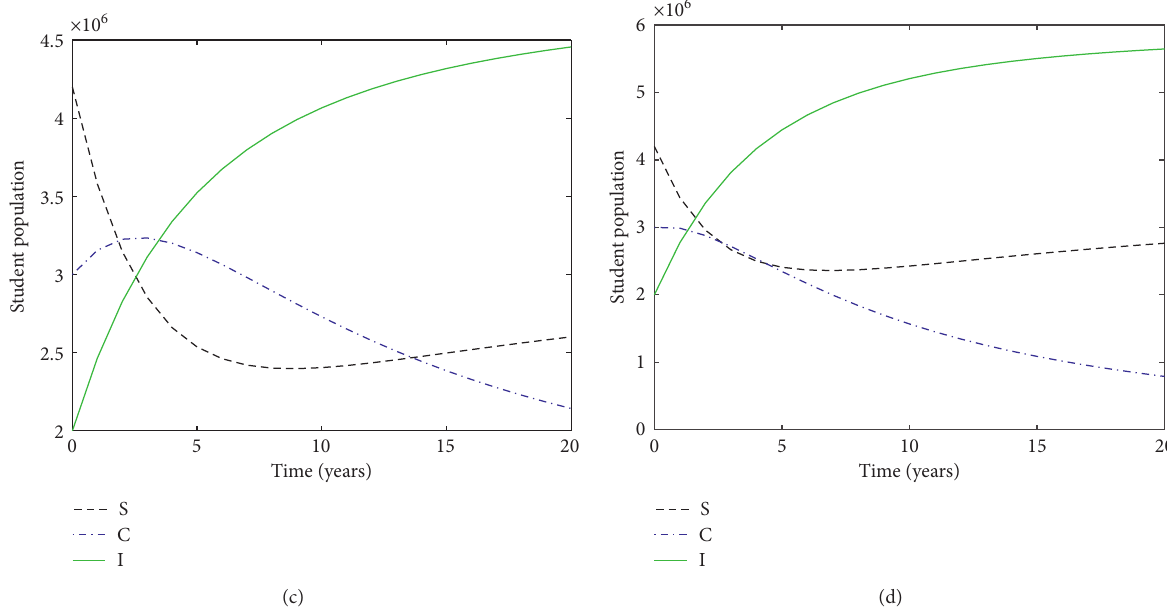
Figure 4: Simulation of the model showing the total number of Susceptible, Morally corrupt, and Immune as a function of time using initial conditions given in Section 2. Parameters used are in Table 2 with (a) σ � 0, α � 0, R